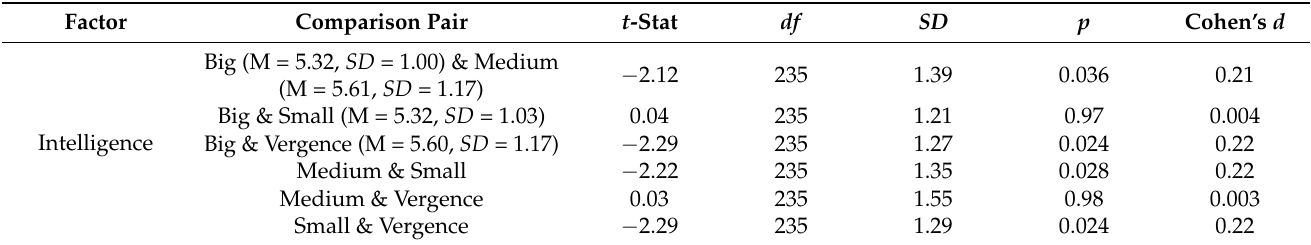
Table 2. Post-hoc comparisons for intelligence ratings in Experiment